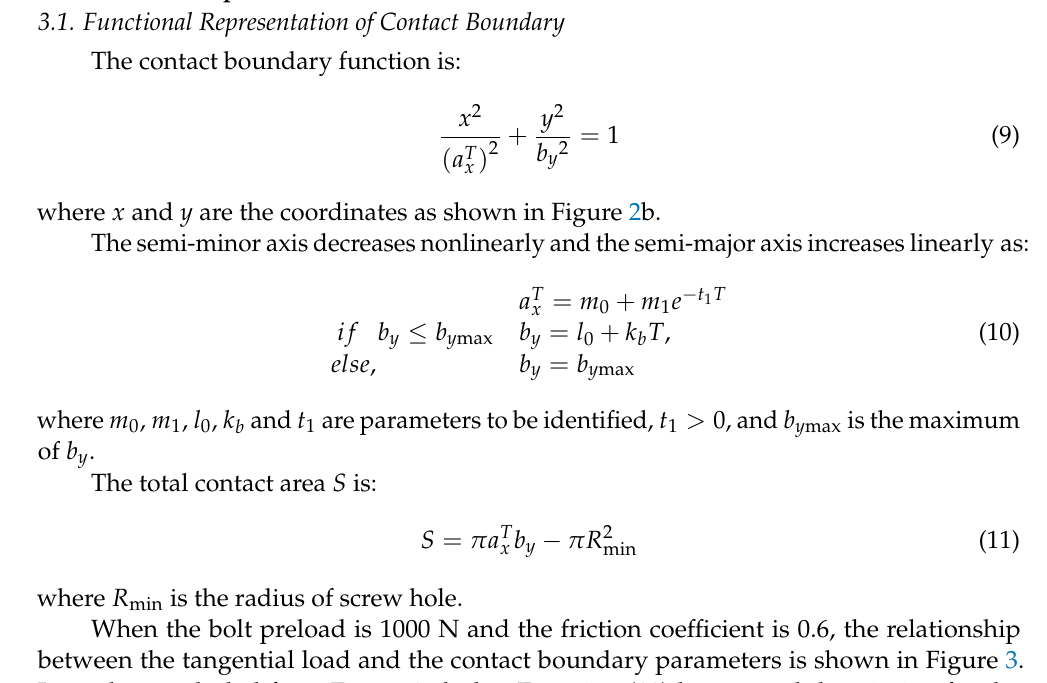
Figure 3. Theoretical curve and calculation data: ( a ) relationship between T and T ; ( b ) relationship between b y and T ; ( c ) relationship between S and T y